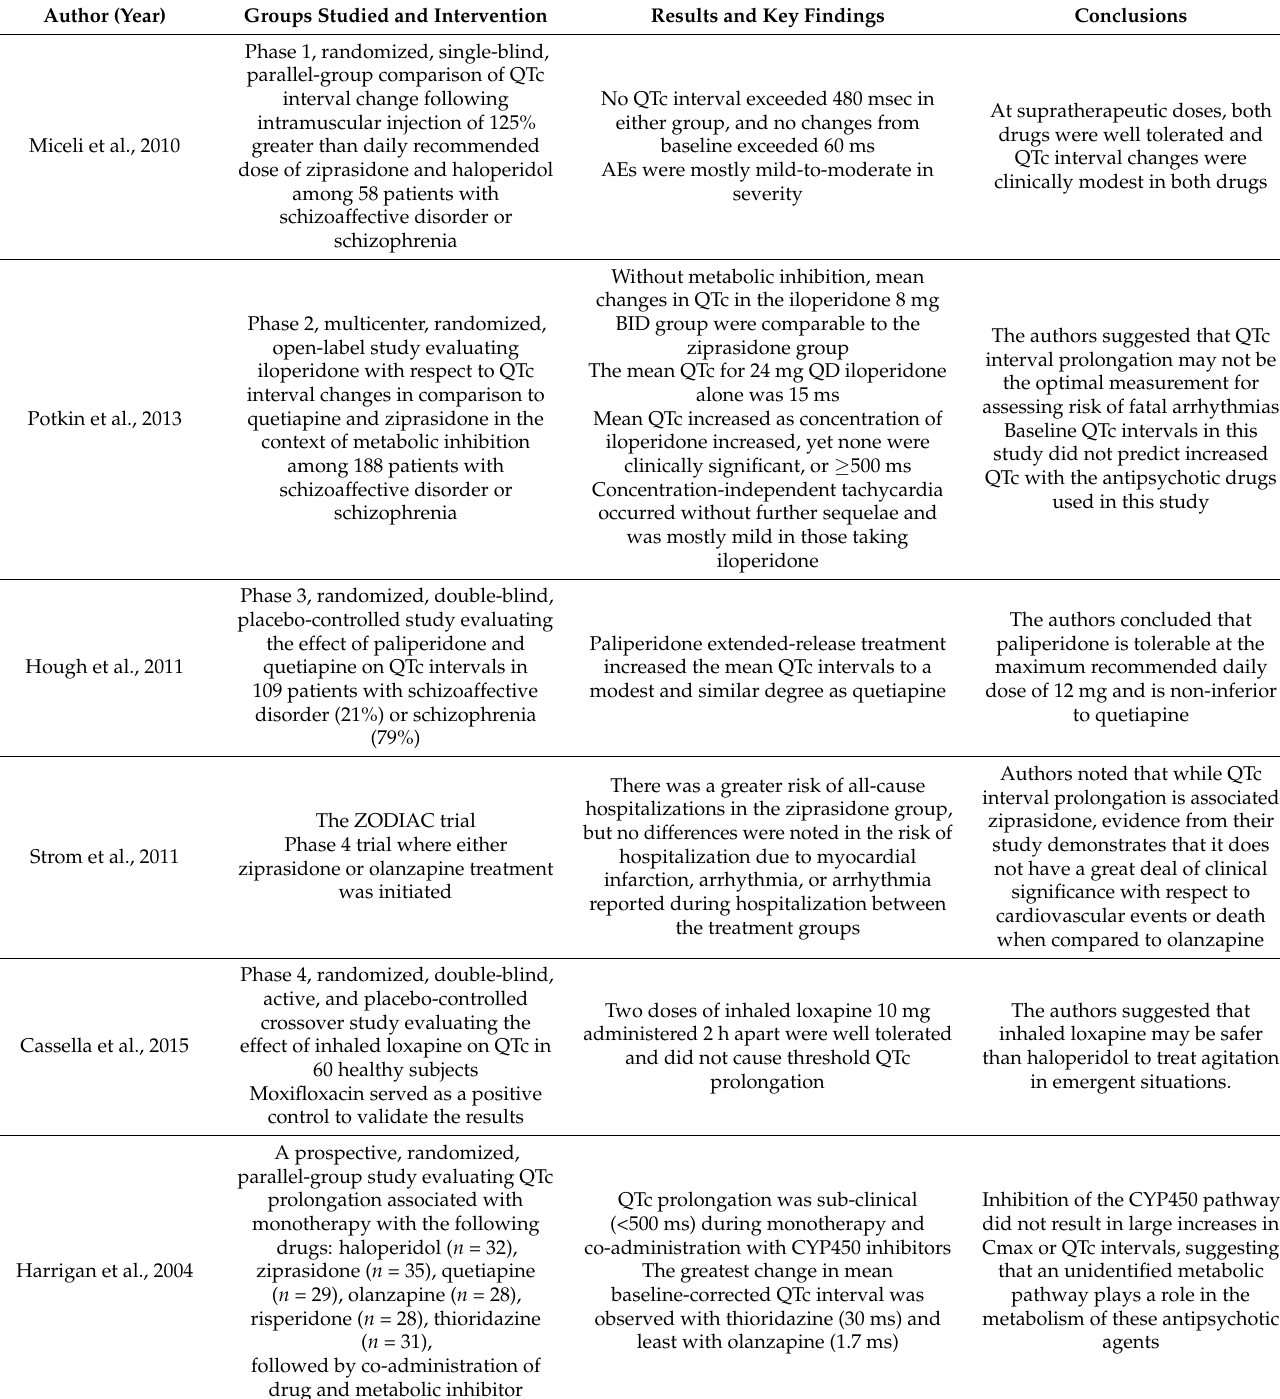
Table 2. Clinical Trials